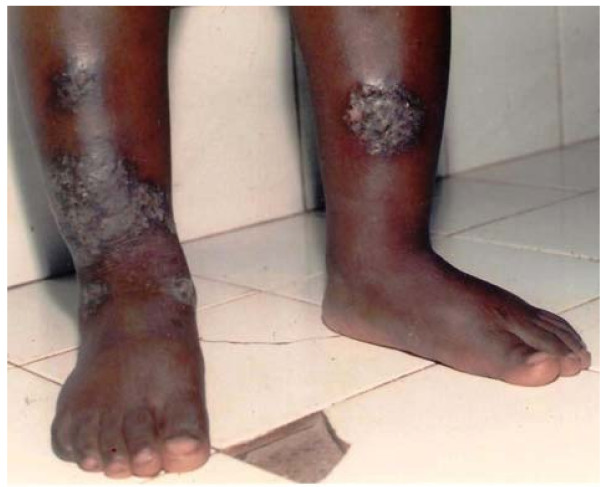
Nummular eczema.